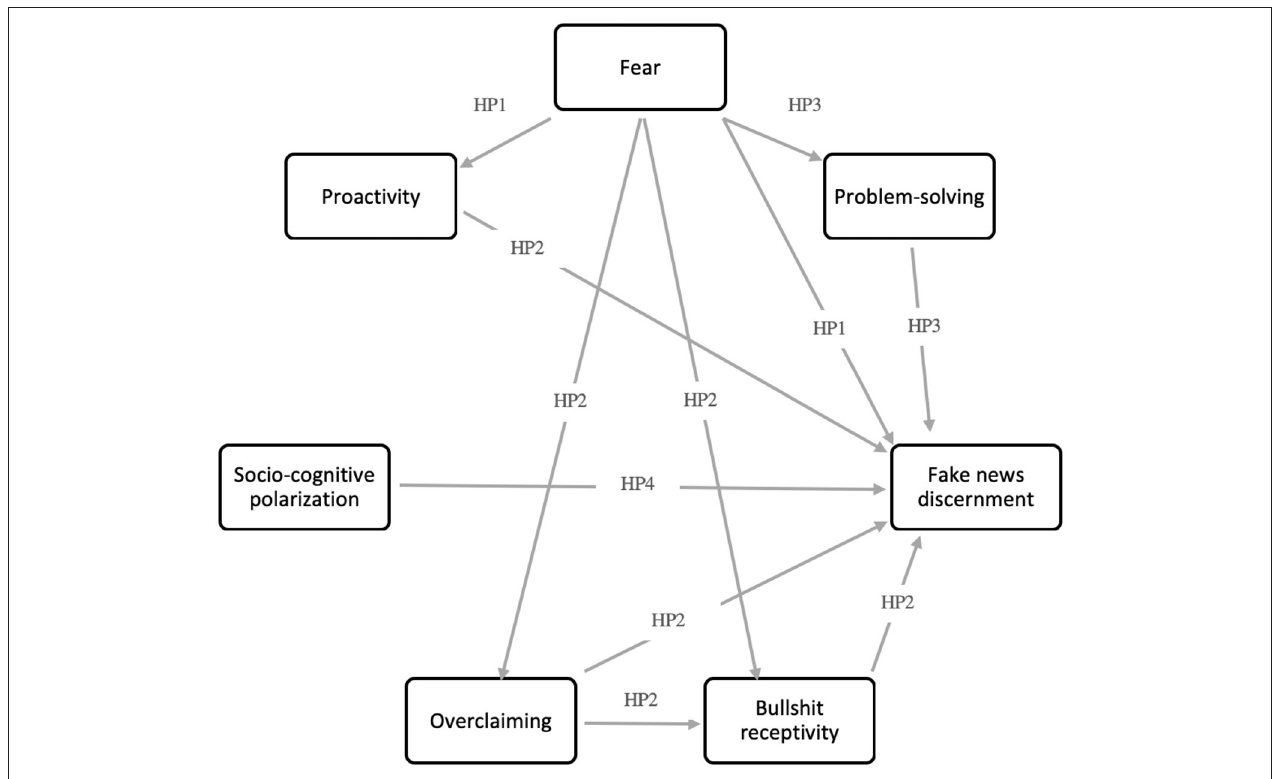
FIGURE 1 | Summary of our hypotheses and results. **significance at p < 0.01; ***significance at p <